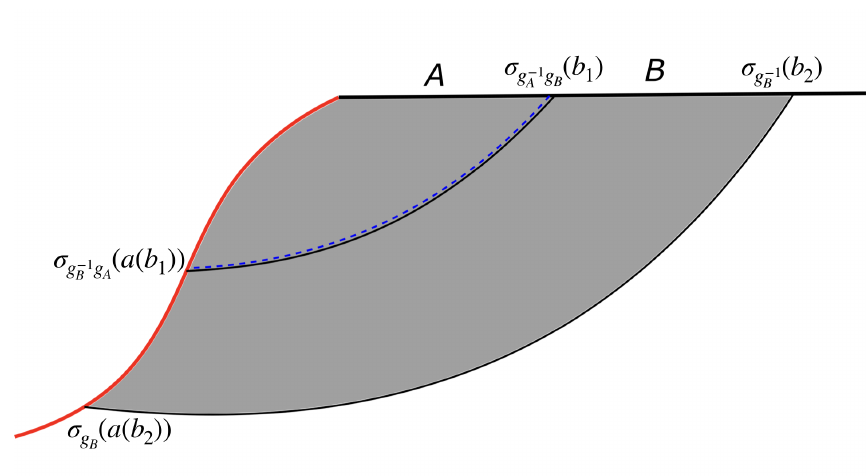
Figure 13: Schematic of the island proposal-II for the entanglement negativity of the adjacent interval configuration in phase-I. The emergent twist operators for the reflected entropy are depicted. Figure modified from [ 68 ]